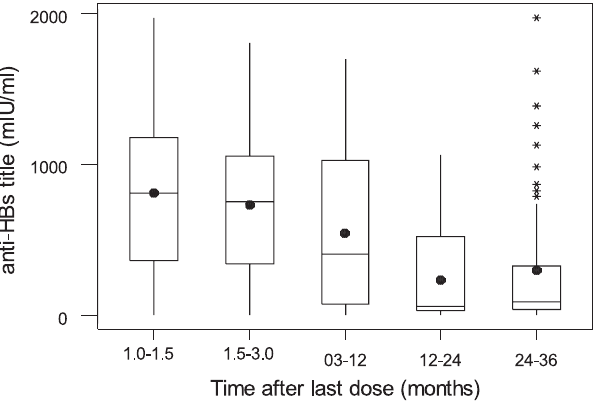
Figure 1 - Box-plot of anti-HBs concentration related to time elapsed after last dose of HBV vaccine - dots represent the average antibody